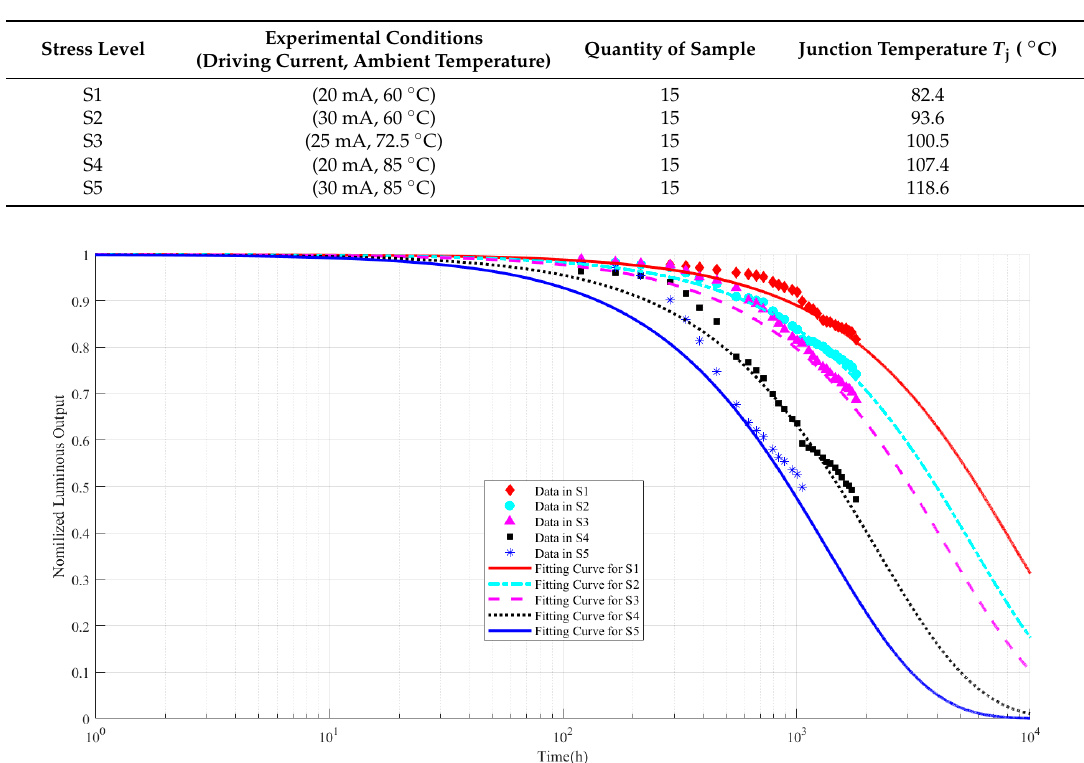
Table 1. Description of stress level conditions.